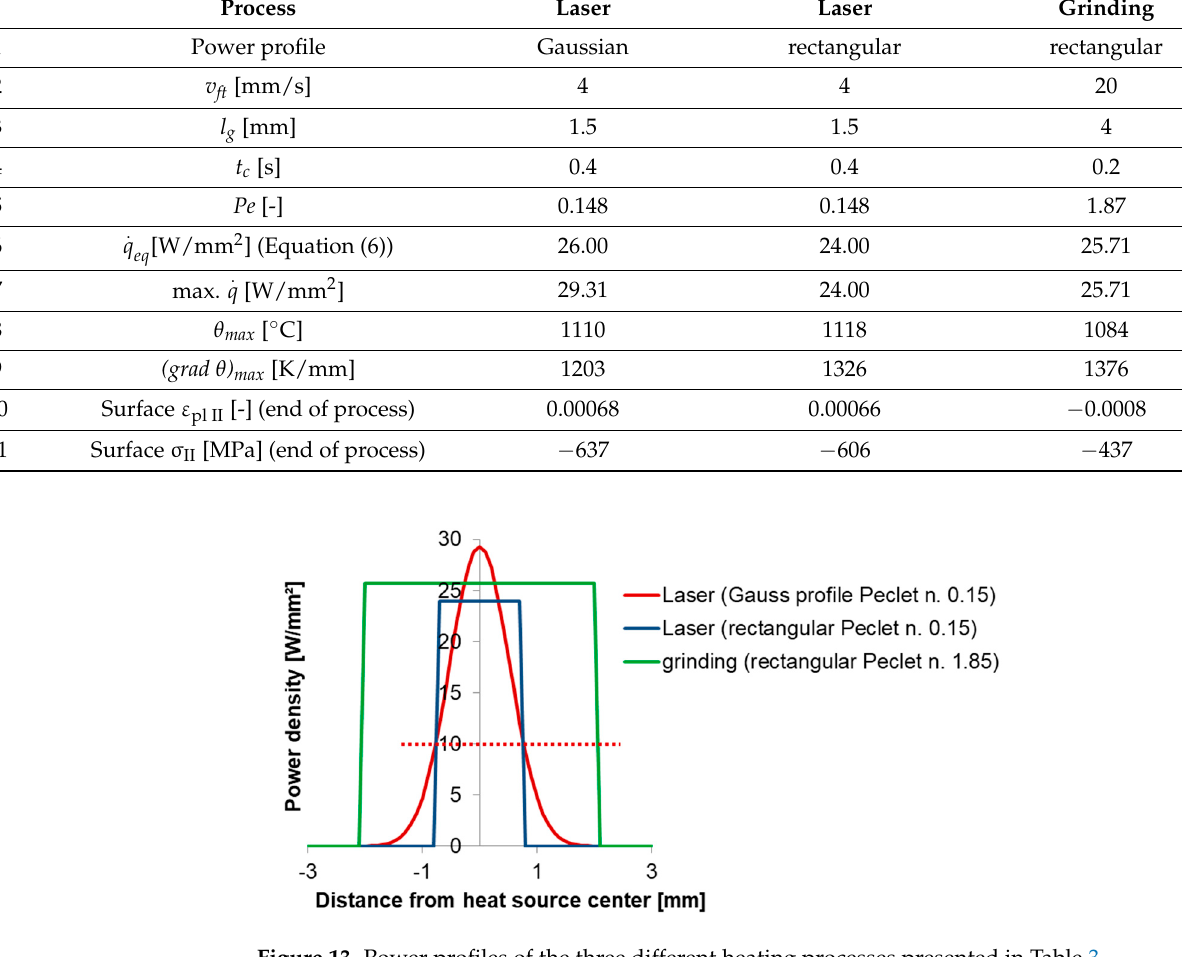
Figure 13. Power profiles of the three different heating processes presented in Table 3. Table 3. Comparison of different power profiles and Peclet